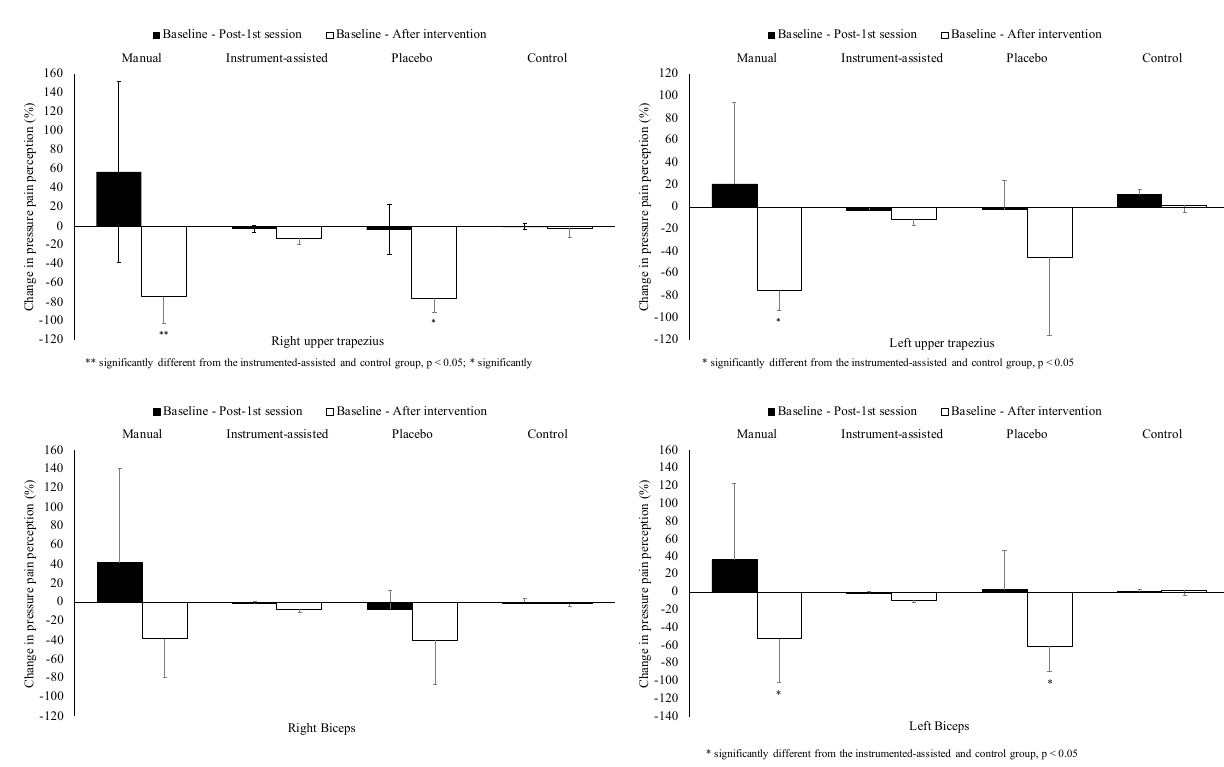
Figure 4. Immediate (baseline—post 1st session) and mid-term (baseline—after intervention) effects of the interventions in pressure pain perception.